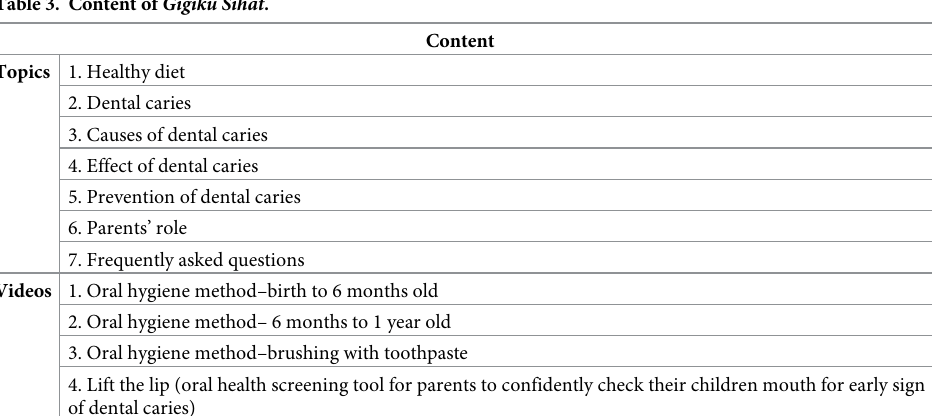
Table 3. Content of Gigiku Sihat